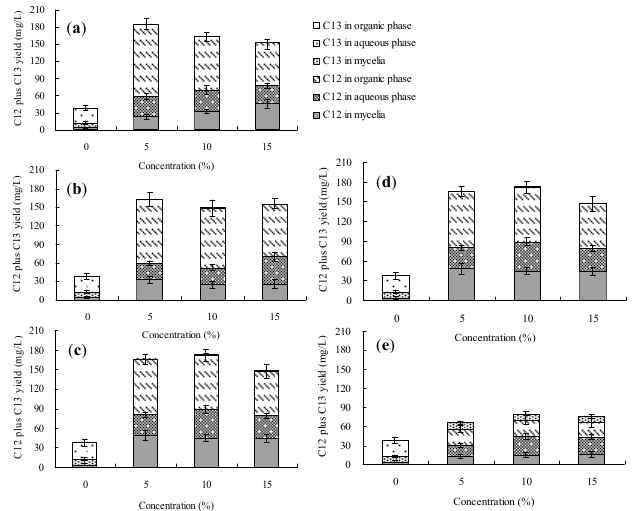
Figure 5. Effects of oleic acid on palmarumycin production in liquid culture of Berkleasmium sp. Dzf12. Oleic acid was applied at 0%, 5%, 10% and 15% on days 0 ( a ); 3 ( b ); 6 ( c ); 9 ( d ) and 12 ( e ) of culture, respectively. The period of culture lasted for 15 days. “C12” means palmarumycin C 12 , “C13” means palmarumycin C 13 . The error bars represent standard deviations from three independent samples.